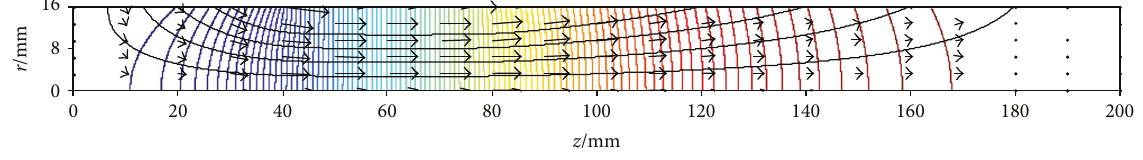
Figure 3: Potential solution of the fl ow fi eld for the case with linear boundary condition.